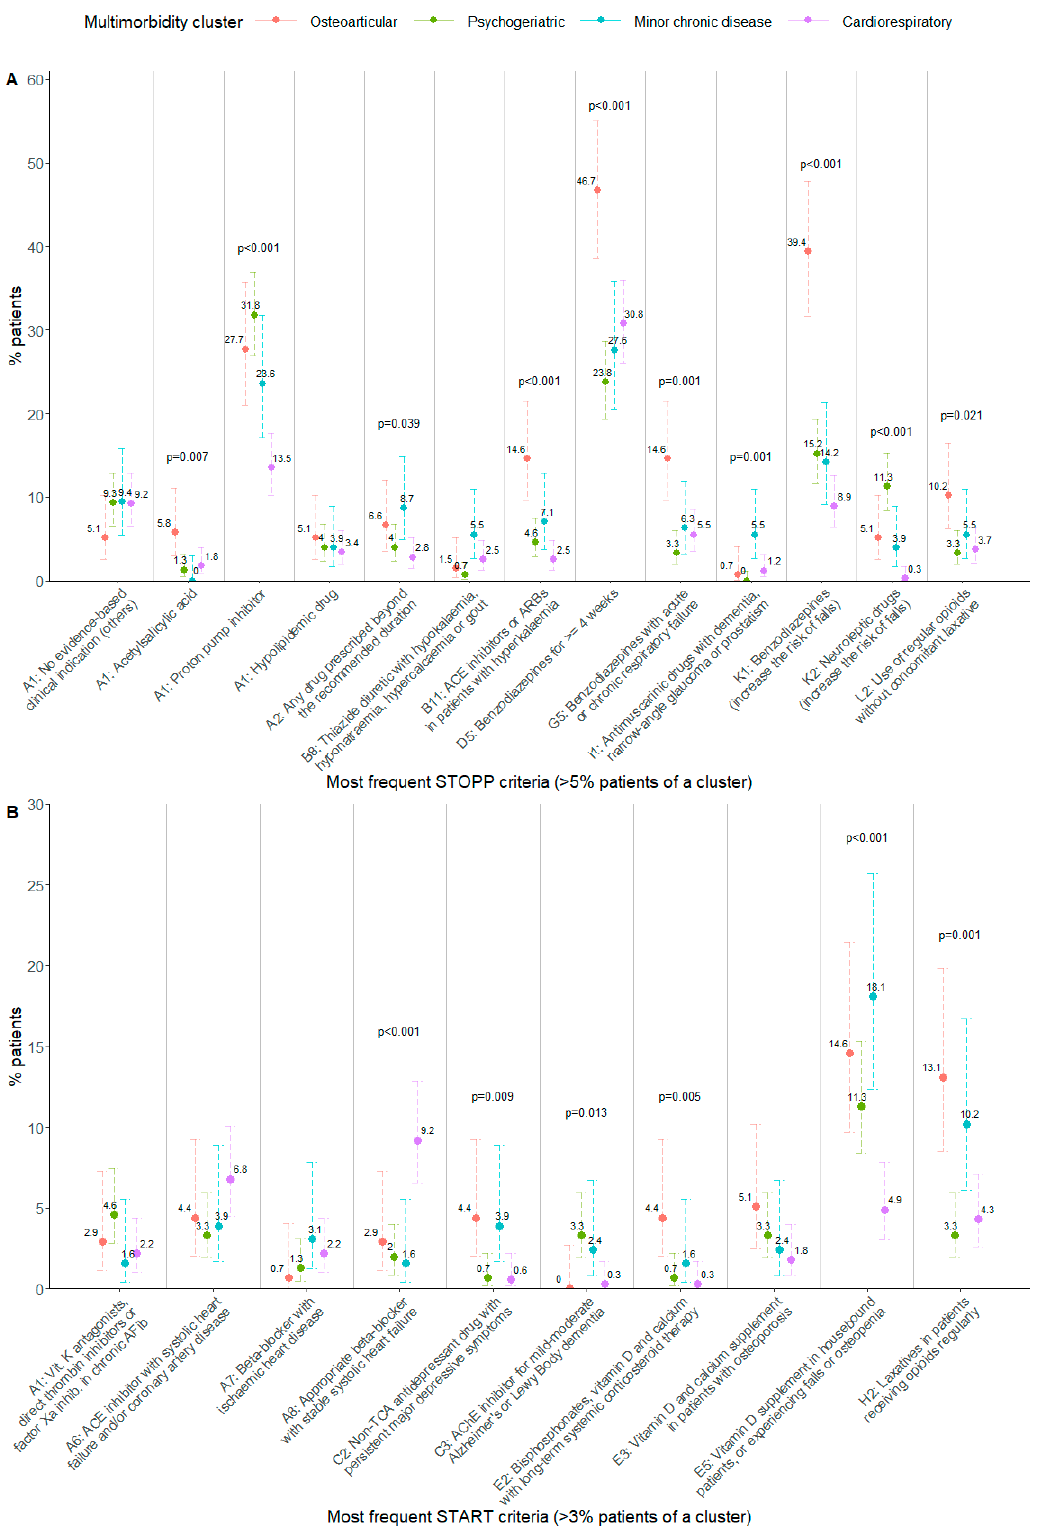
Figure 1. ( A ): Percentage of patients per cluster having the most frequent STOPP PIM criteria. ( B) : Percentage of patients per cluster having the most frequent START PPO criteria. Fisher’s exact test p -value: p -values are shown in the figure when p < 0.05. Error bars show 95% confidence interval for the estimated proportion. ACE: angiotensin converting enzyme; ARB: angiotensin II receptor blocker; AFib: atrial fibrillation; TCA: tricyclic antidepressant; AChE: acetylcholinesterase.